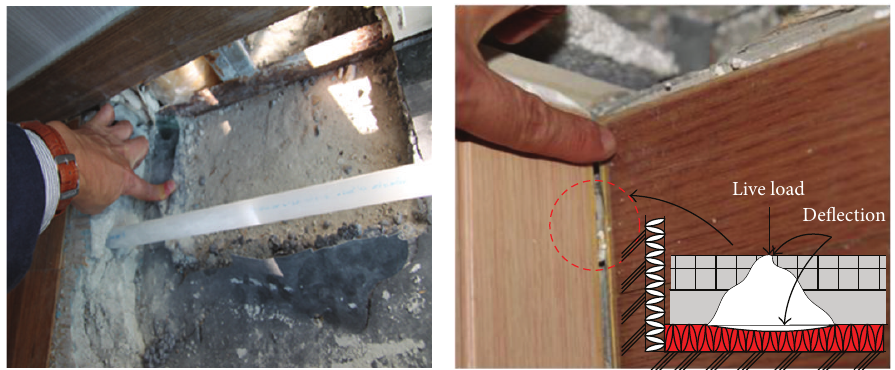
Figure 1: Deflection of floating floors in an apartment